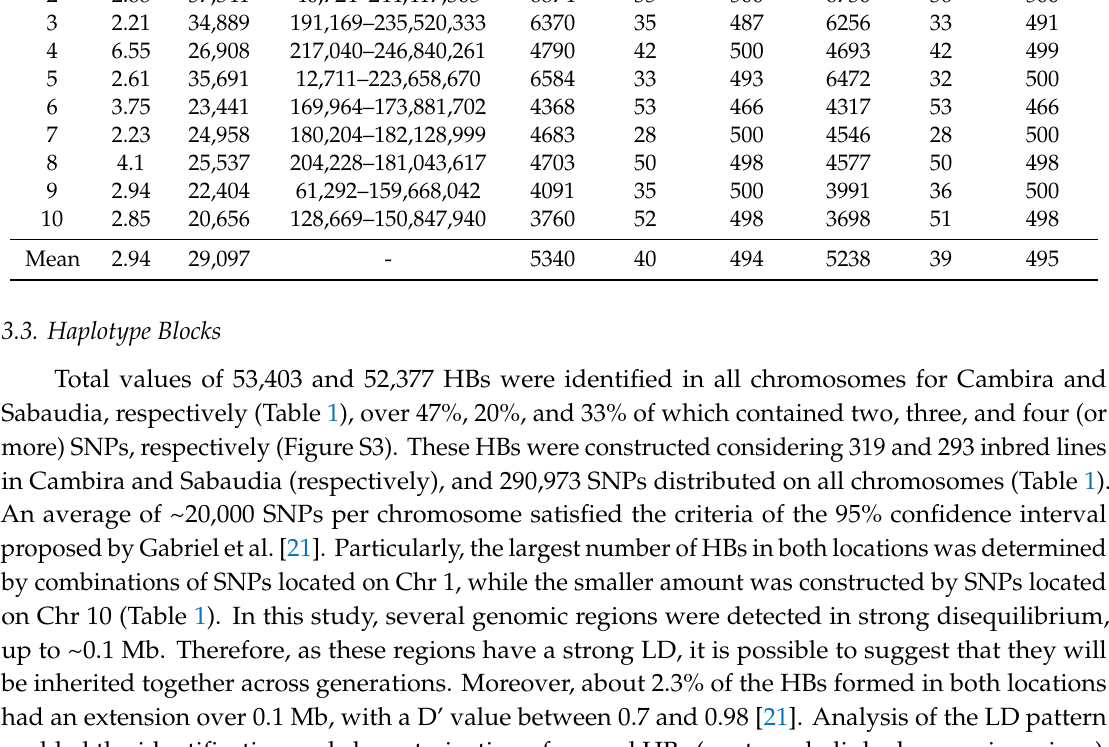
Table 1. Summary of information on linkage disequilibrium (LD) and haplotype blocks (HBs) determined in inbred lines of tropical maize. Chr corresponds to the chromosome number; N ◦ SNP indicates the number of single nucleotide polymorphisms (SNPs) detected on each chromosome; N ◦ HB is the number of haplotype blocks; Size HB and Max(kb) correspond to the maximum number of SNPs forming a haplotype block and the maximum size (in kb) for a haplotype block, respectively. Position (pb) ◦ Chr LD N SNP First-Last